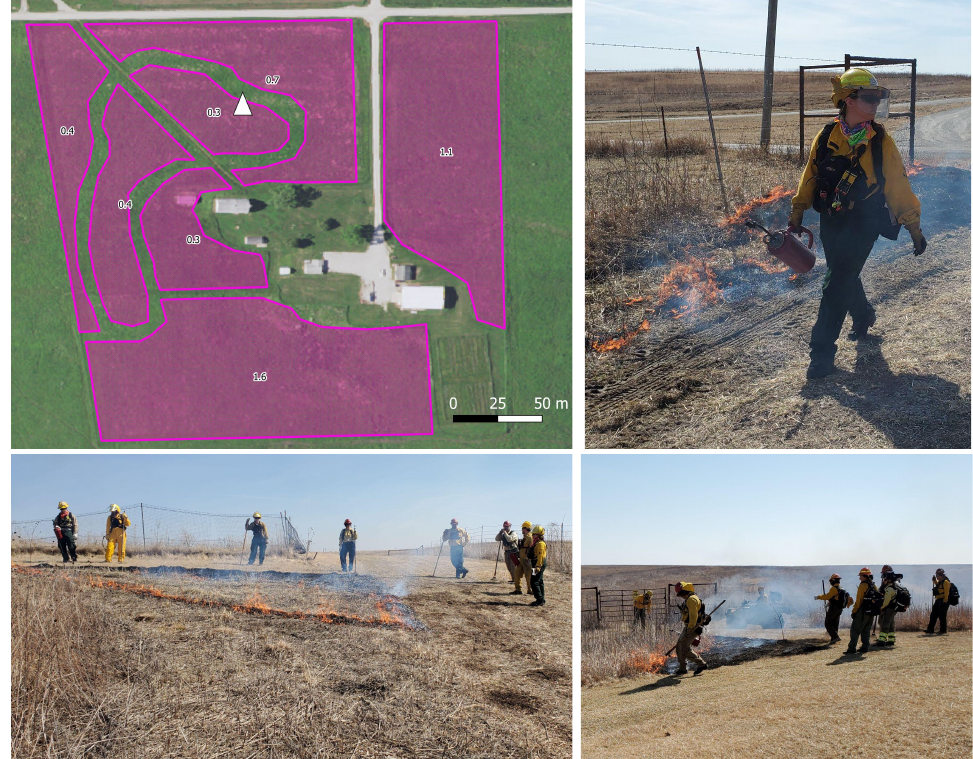
Figure 6. The seven sub-units around the Dunn Ranch Prairie headquarters were used for the training live fire exercises, in which squads swapped out as the burn crew among sub-units, and squad leadership rotated each time the squad was up to burn. Numbers denote hectares of each sub-unit and the white triangle indicates where the leadership allowed a spot fire to slop over the walking trail. Note that the perimeter of the headquarters area is maintained as lawn, and as such was short and green at the time of the workshop, serving as excellent